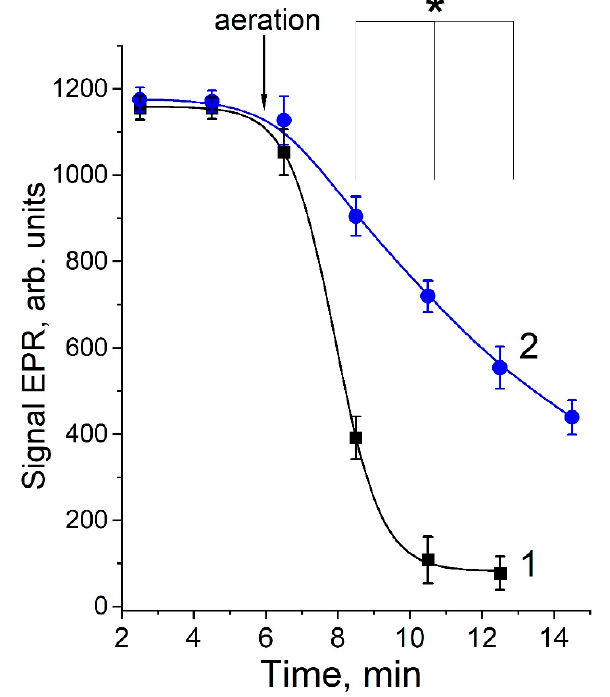
Figure 8. Kinetics of DNICs’ destruction associated with the products of lysine interacting with MG during aeration. The decomposition of the DNICs arising from mixing 160 mM lysine, 160 mM MG and 0.5 mM phosphate DNICs (1); in the presence of SOD (600 units/mL) (2). The reaction mixture was in a nitrogen atmosphere for the first 6 min, after which the incubation continued during aeration. Results are depicted as the mean with S.E.M. of three independent experiments ( n = 3). Student’s t-test (* p ≤ 0.05 for all point after 8 min).